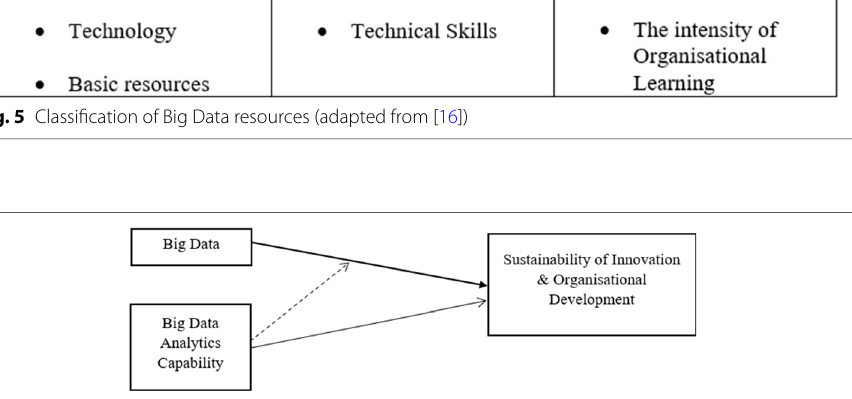
Fig. 6 Theroretical framework illustrating how BDA resources influence innovation sustainability and organizational development (adapted from